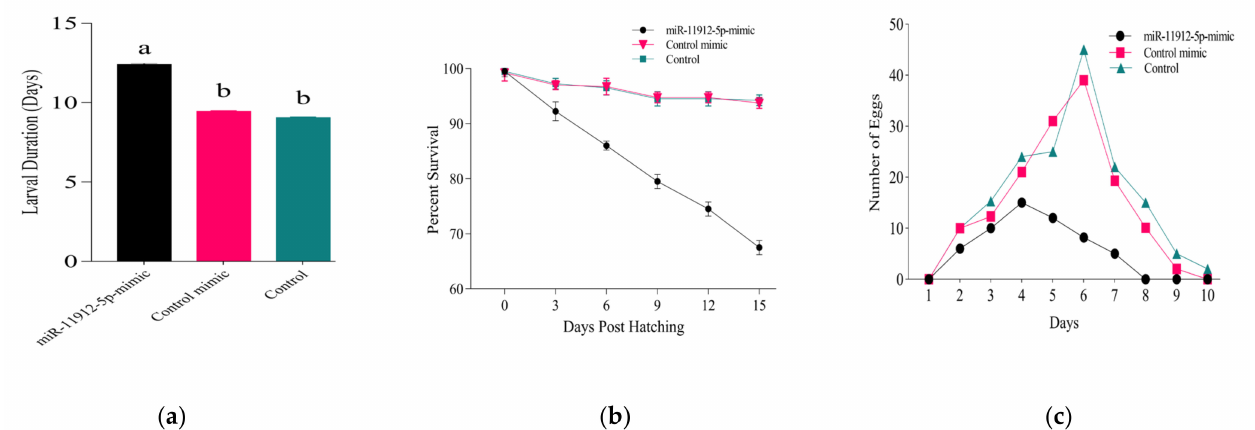
Figure 7. Impact of mimic administration on P. xylostella larval development, survival and fecundity. ( a ) average larval duration; ( b ) survival percentage of P. xylostella larvae fed on miR-11912-5p-mimc, control mimic and control; ( c ) average adult fecundity from start of the egg laying. Error bars represent standard deviations of mean values from independent replicates. Letters indicate significant differences at p <